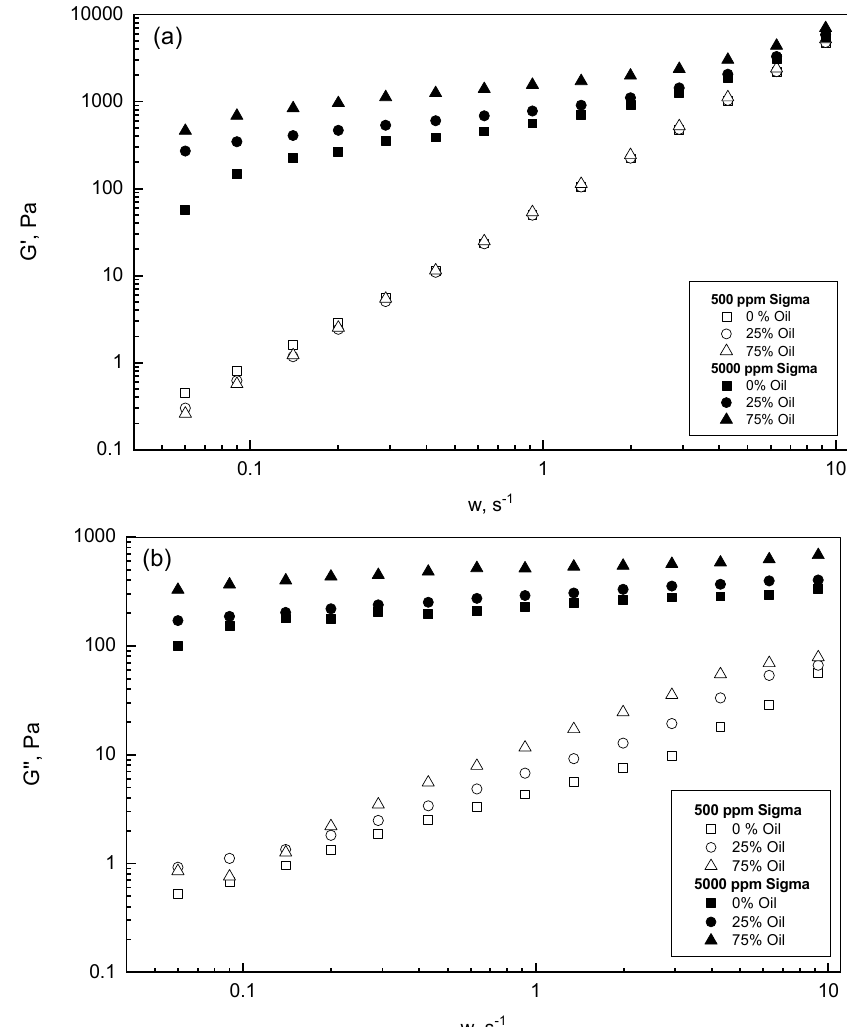
Figure 6. G' and G'' behaviors of Sigma emulsions. Figure 6. G (cid:48) ( a ) and G” ( b ) behaviors of Sigma Figure 6. G’ ( a ) and G’’ ( b ) behaviors of Sigma emulsions.